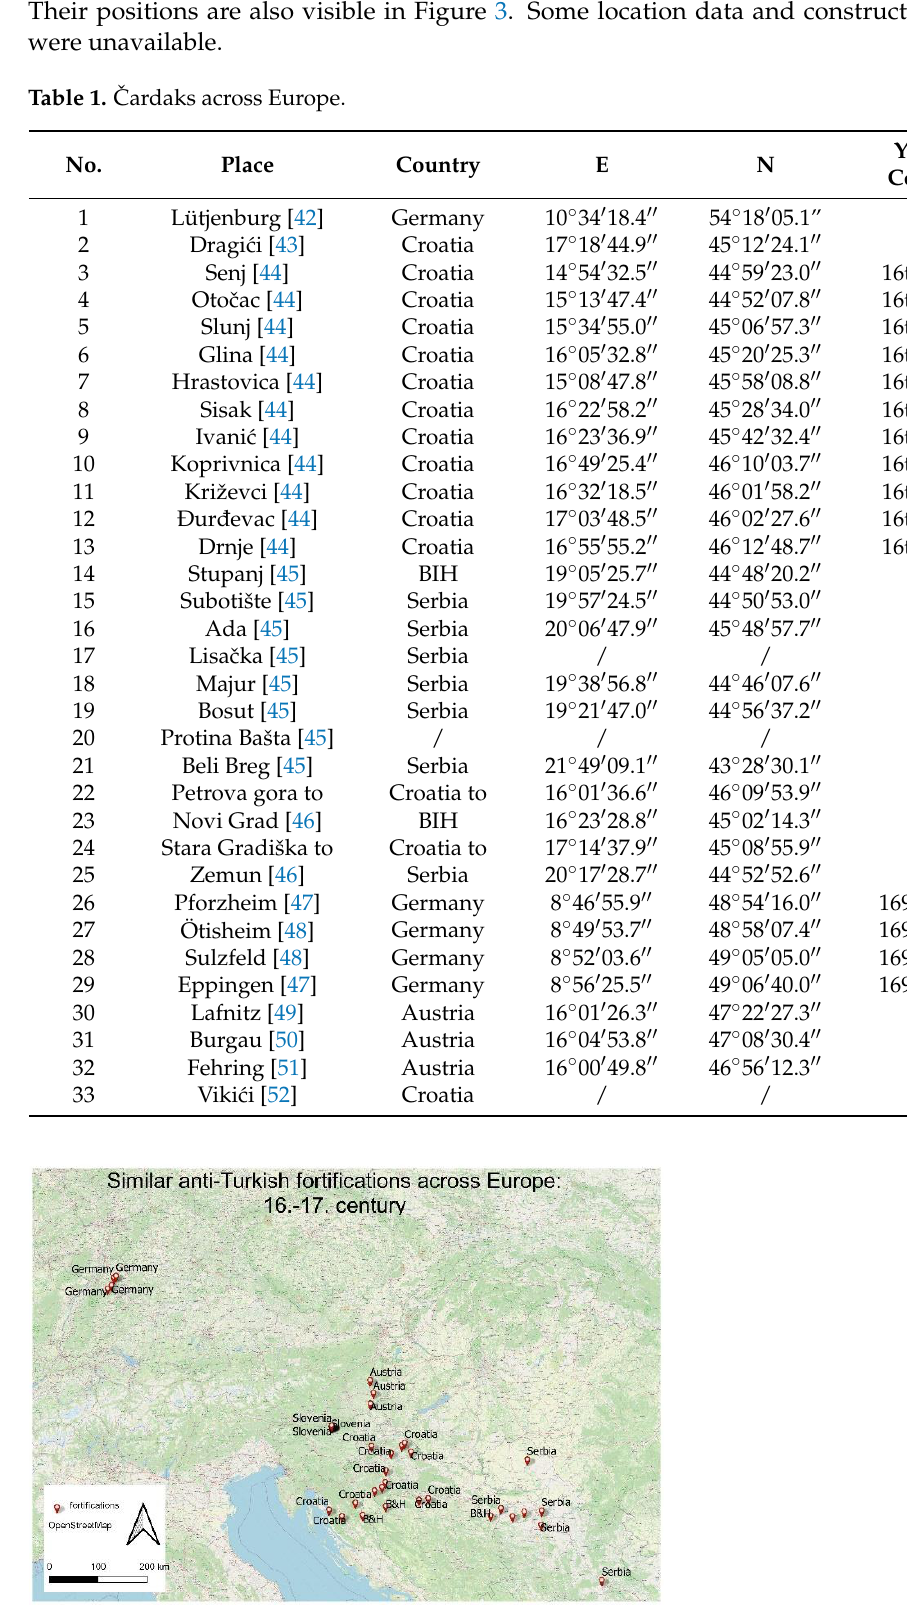
Figure 3. Similar watchtowers across